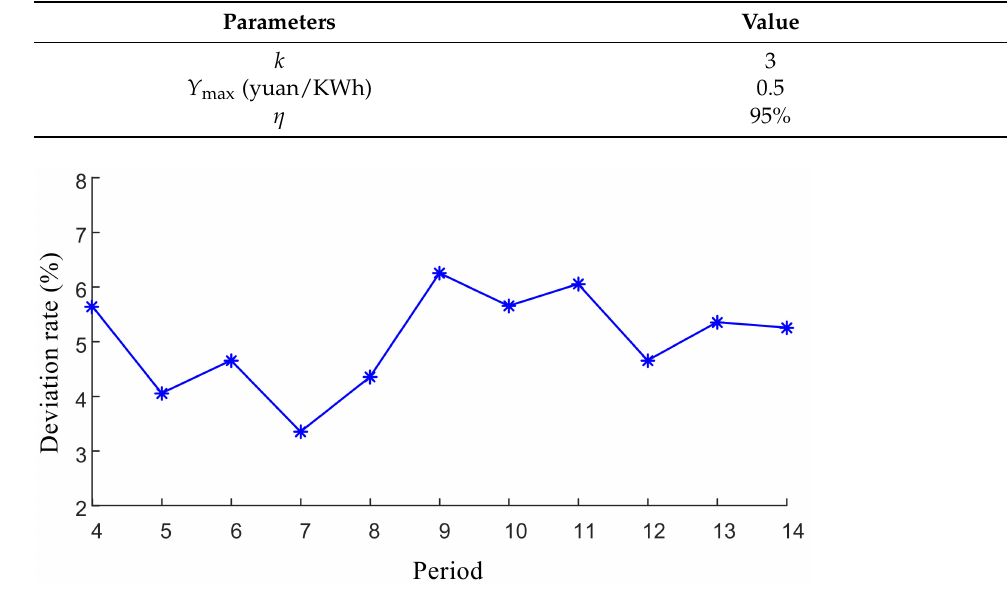
Figure A1. The predicted value of controllable capacity deviation rate of the HBES aggregation cluster.